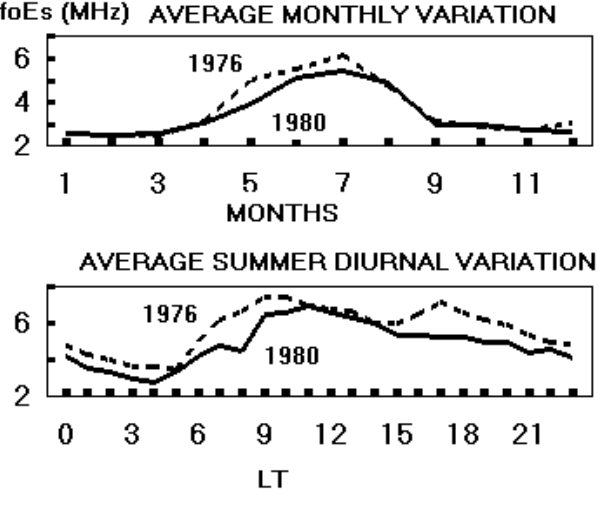
Fig. 7. Examples of average fo Es variations for two years at Kokobunji. The diurnal variation is shown for